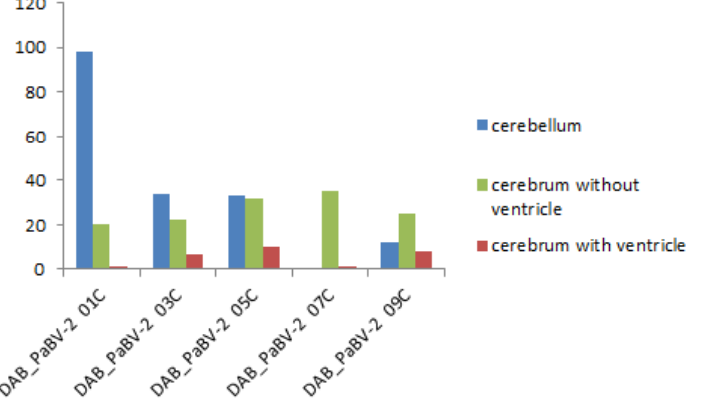
Figure 7. Parrot bornavirus (PaBV) antigen distribution in the brain of trial B group 4 (PaBV-2 inoculation in the chorioallantoic membrane). The y -axis shows the number of PaBV antigen-positive cells counted in one slide (200 × total magnification). The PaBV antigen distribution is similar to trial B group 3. There was no significant difference between the cerebellum and the cerebrum without ventricles and between the cerebellum and the cerebrum with ventricles. There was a significant difference between the cerebrum with and without ventricles. The x -axis shows each individual embryo ( n = 5, laboratory number).